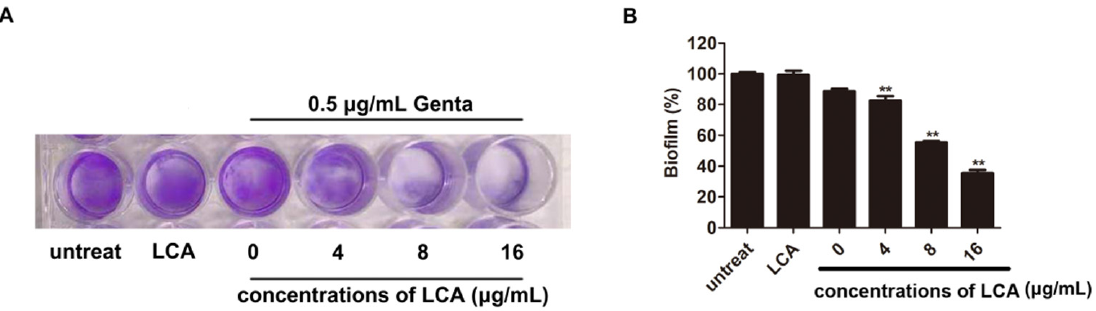
Figure 10. LCA combined with Genta inhibited L. monocytogenes biofilm formation. ( A ) Overall image of L. monocytogenes biofilms with the indicated treatment. ( B ) L. monocytogenes biofilms were quantified by determining the absorbance value of crystal violet at 570 nm, ** p < 0.01.